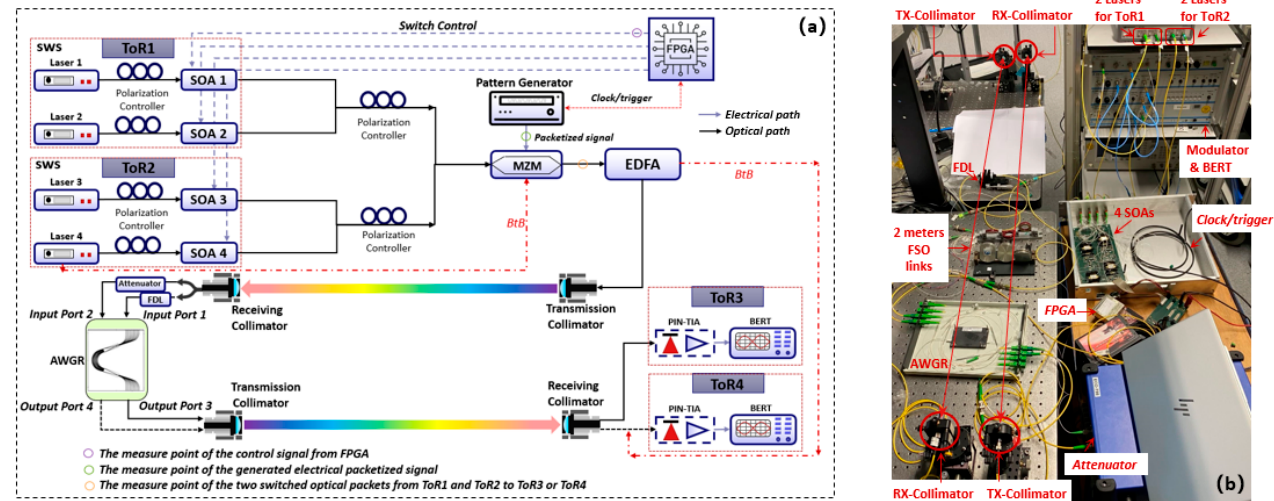
Figure 8. ( a ). Experimental setup for 50-gigabyte-per-second end-to-end optical packet-switch transmission; ( b ) the actual setup.